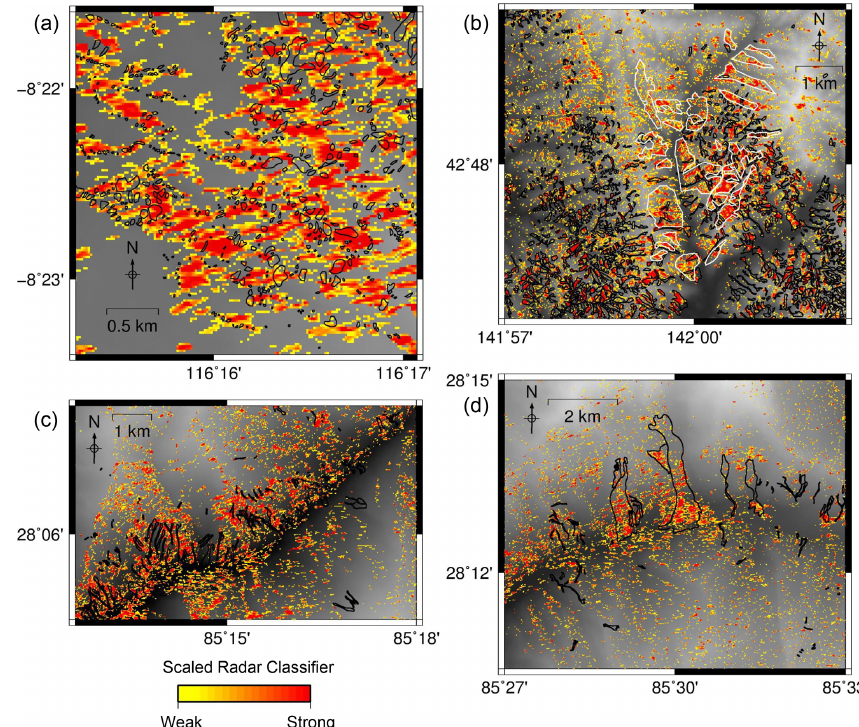
Figure 6. (cid:49) C_sum classification surface calculated using ALOS-2 data displayed at 20m × 22m resolution with mapped landslide polygons in black. The 10% of pixels most likely to be landslide pixels are coloured from yellow (least likely) to red (most likely). (a) Lombok: track A129a for the 5 August 2018 event (Ferrario, 2019). (b) Hokkaido: track A018d, landslide polygons from Zhang et al. (2019). White polygons show the locations of forested areas mapped using Sentinel-2 data. (c, d) Nepal: track A157a(C), landslide polygons from Roback et al.